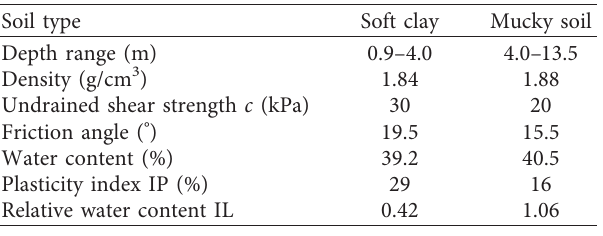
Table 1: Parameters of soft clay and mucky